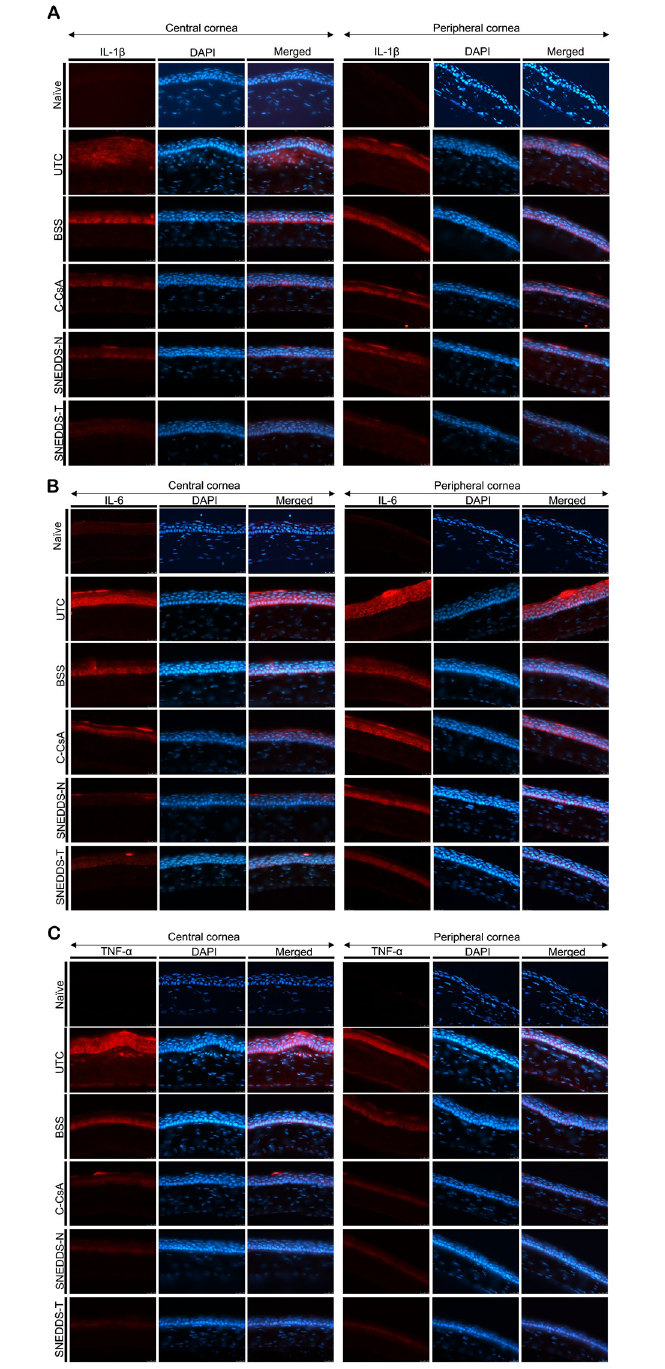
Fig 4. Representative images for immunofluorescent staining of inflammatory cytokines including (A) IL-1 β , (B) IL-6 and (C) TNF- α in central and peripheral cornea in the UTC, BSS-treated, C-CsA-treated, SNEDDS-N- treated and SNEDDS-T-treated